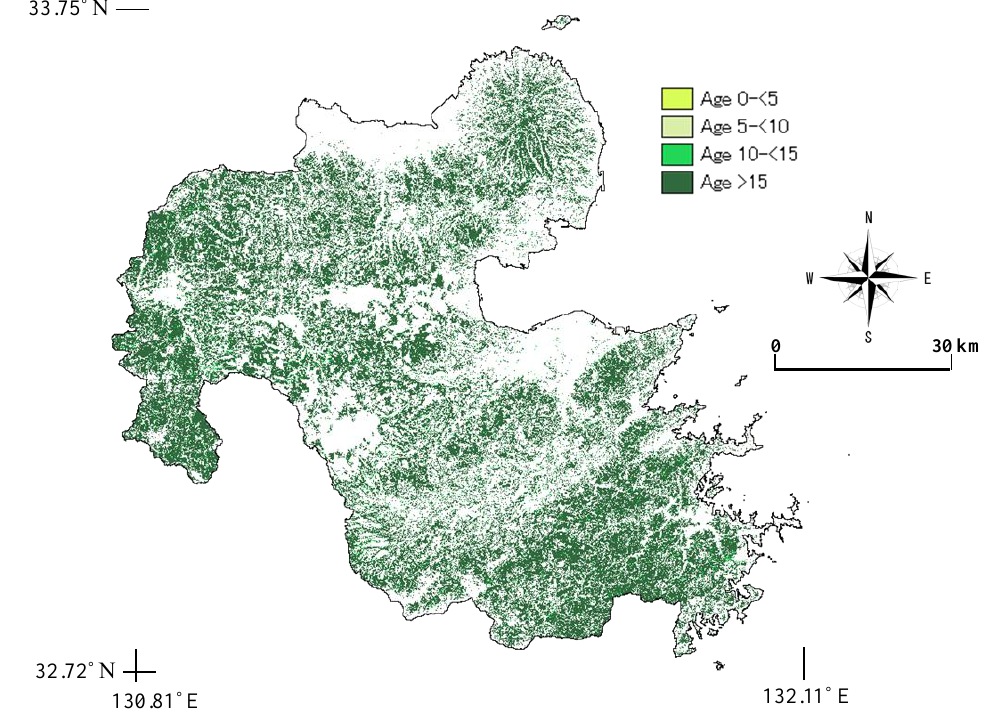
Figure 8. Area of coniferous forests (ceda–cypress) divided per tree age using the NDVI values.